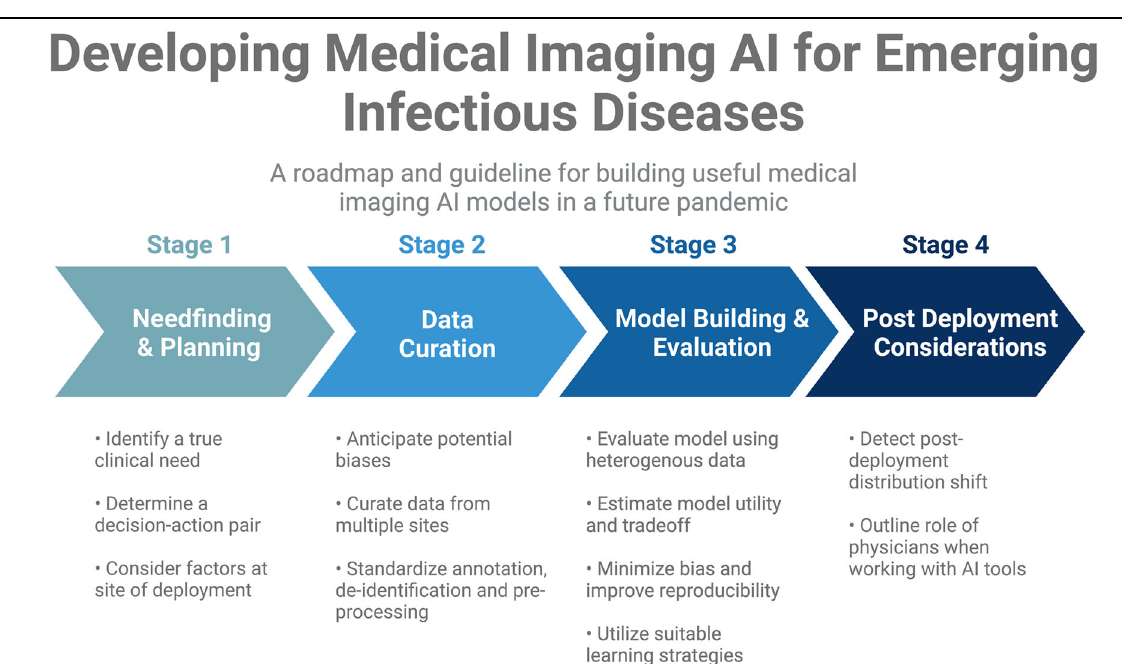
Fig. 1 | The four stages of building useful medical imaging AI models for emerging infectious diseases. We provide recommendations and guidelines for the four stages of medical imaging AI development process in each section of this manuscript, namely: need fi nding, dataset curation, model development and